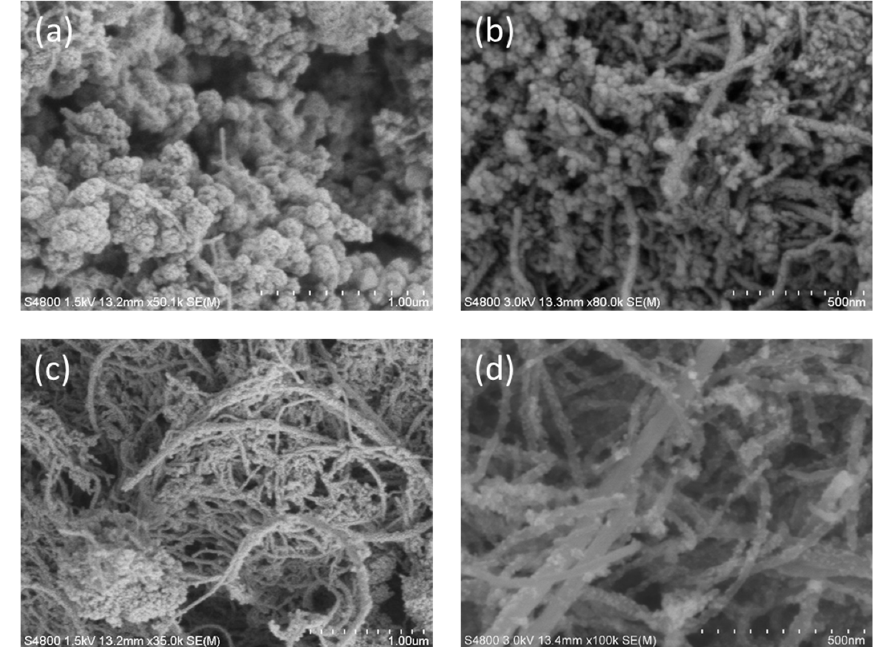
Figure 4. SEM images of the NiFe 2 O 4 /MWCNTs composites synthesized with different amount of carbon nanotubes ( a ) 0.05 g; ( b ) 0.1g; ( c ) 0.15 g and ( d ) 0.2 g.